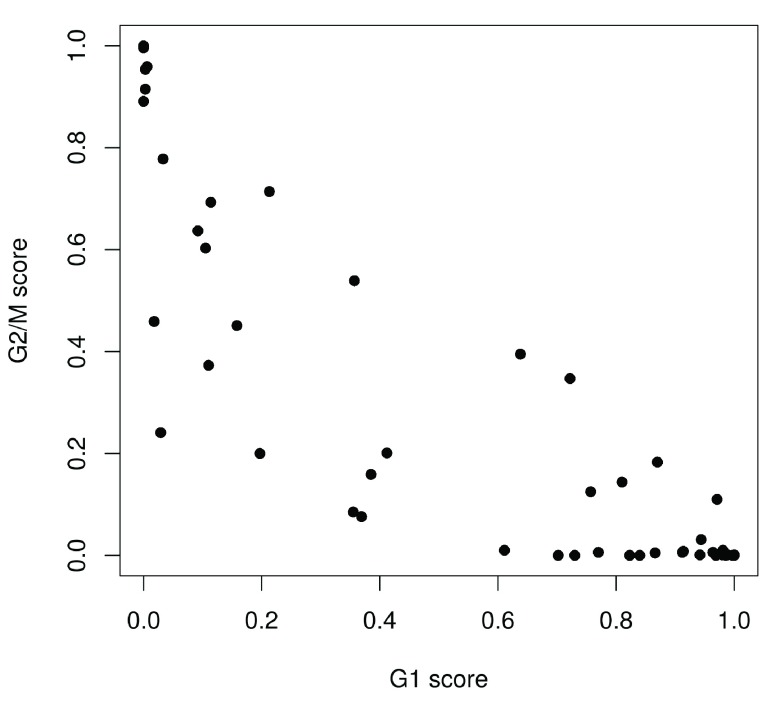
Cell cycle phase scores from applying the pair-based classifier on the T
H2 dataset, where each point represents a cell.